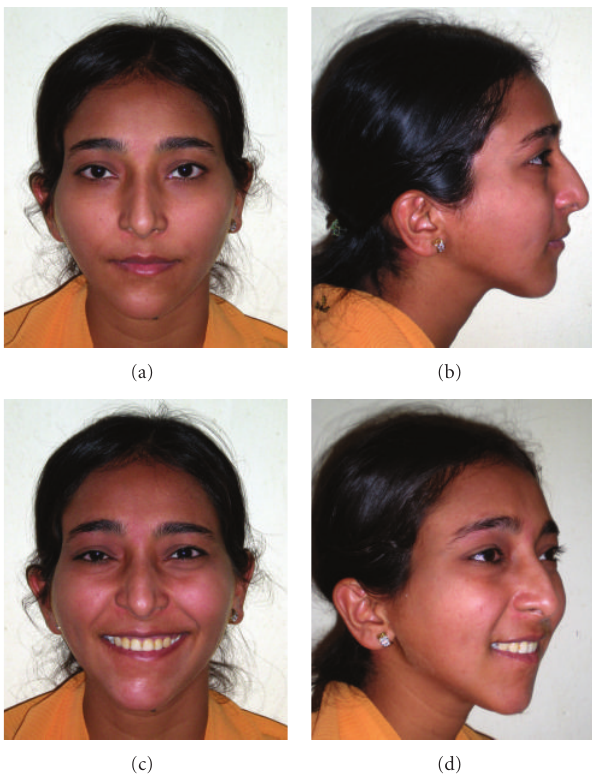
Figure 6: (a)–(d): after completion of orthodontic treatment and 7mm advancement genioplasty, facial esthetics was improved considerably.